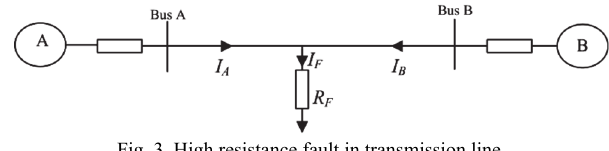
Fig. 3. High resistance fault in transmission